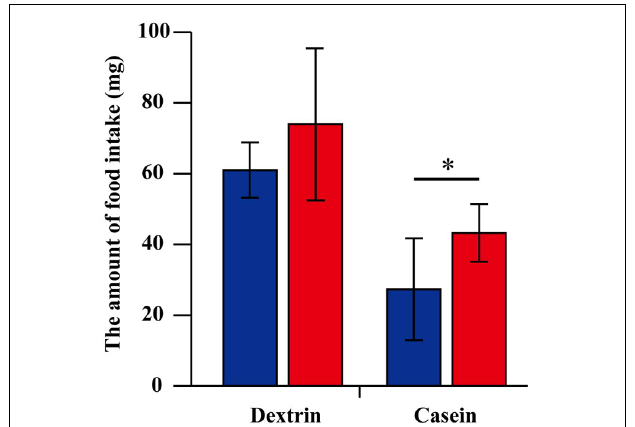
FIGURE 4 | The amount of dextrin and casein consumption. The amount of dextrin and casein consumption. The value is computed using the amount of consumption of carbohydrate-rich and protein-rich “generic” diet tablets and the rate of the nutrients contained in each “generic” tablet. The amount of dextrin consumption is estimated by summing up 30% of the consumed amount of carbohydrate-rich tablet and 3% of the consumed amount of protein-rich tablet. The amount of casein consumption is estimated by summing up 30% of the consumed amount of protein-rich tablet and 3% of the consumed amount of carbohydrate-rich tablet. N = 7, Mean ± SD . Data were statistically analyzed by Student’s t- test. P- values less than 0.05 were considered to be statistically significant. ∗ P < 0 .